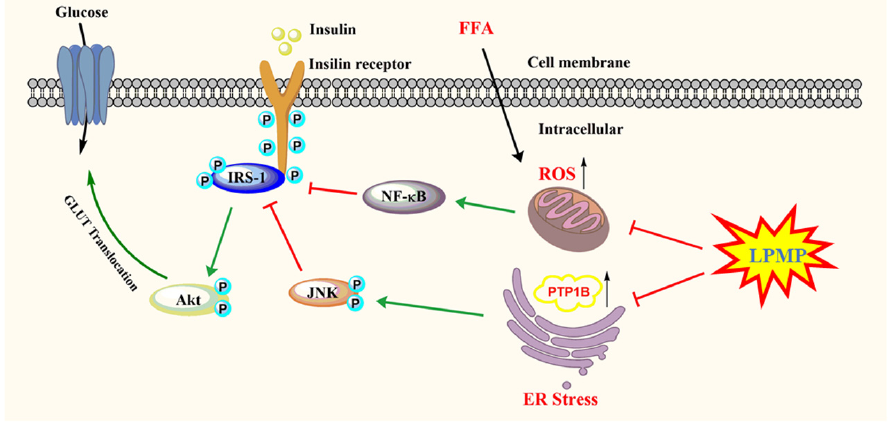
Figure 10. The proposed molecular mechanisms of the anti-diabetes effect of